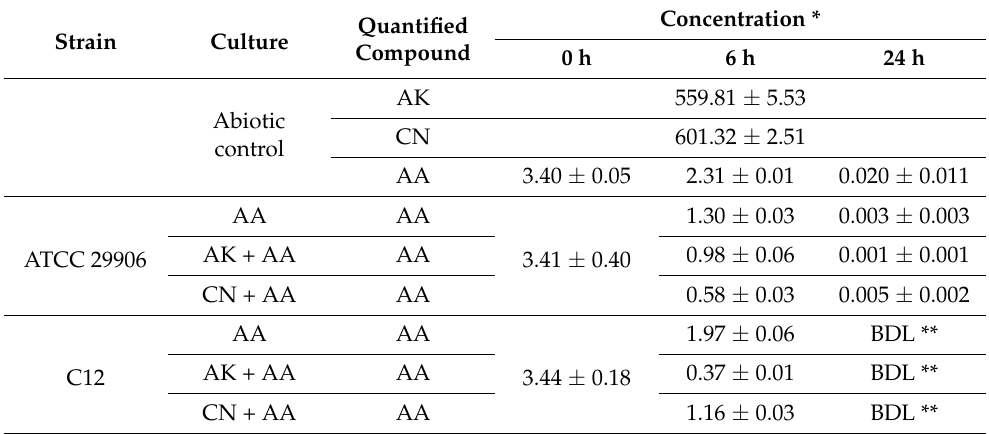
Table 1. The results of the HPLC–MS 2 quantitative analyses of amikacin, gentamicin, and ascorbic acid in abiotic and biotic